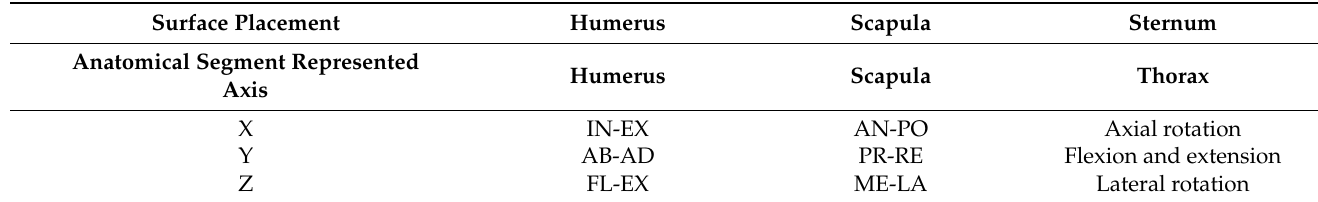
Table A1. Equivalence of the X, Y and Z axes with the movement that they represent.